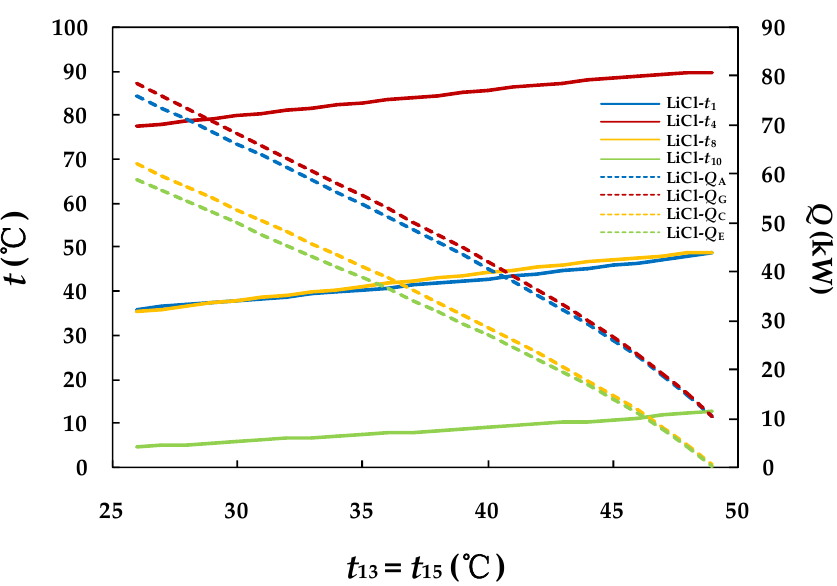
Figure 18. Variation of the exit temperature and heat capacity of each component with the cooling water inlet temperature for LiCl-H 2 O absorption chiller.